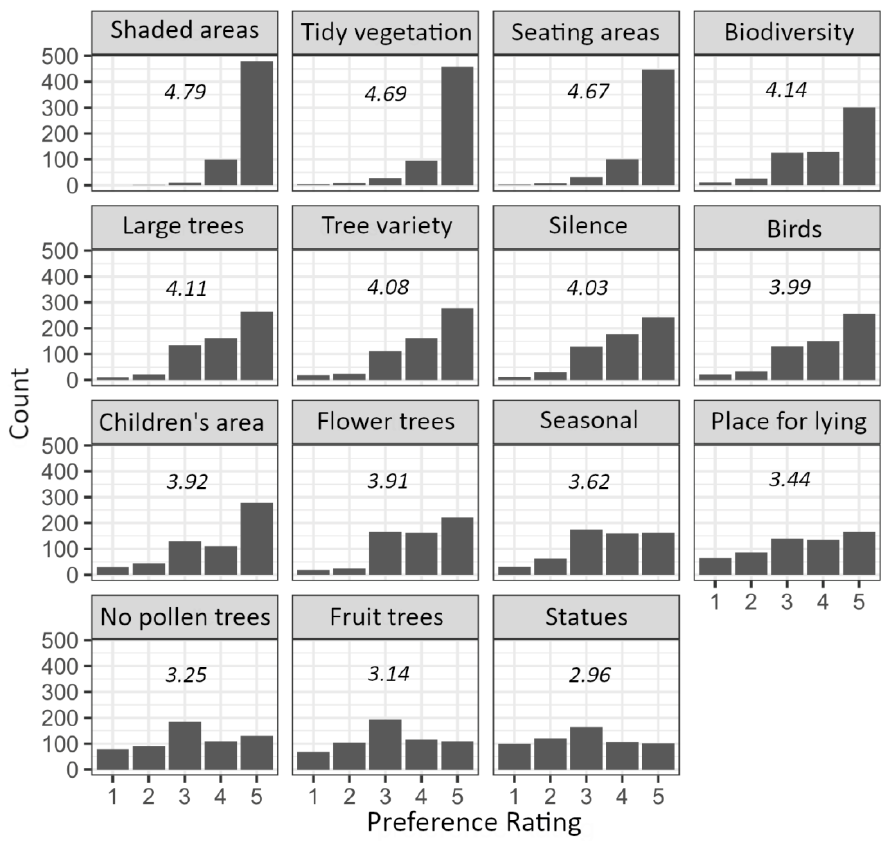
Figure 3. Preference rating from 1 (unimportant) to 5 (very important) for various park features with the mean average vote in italics.